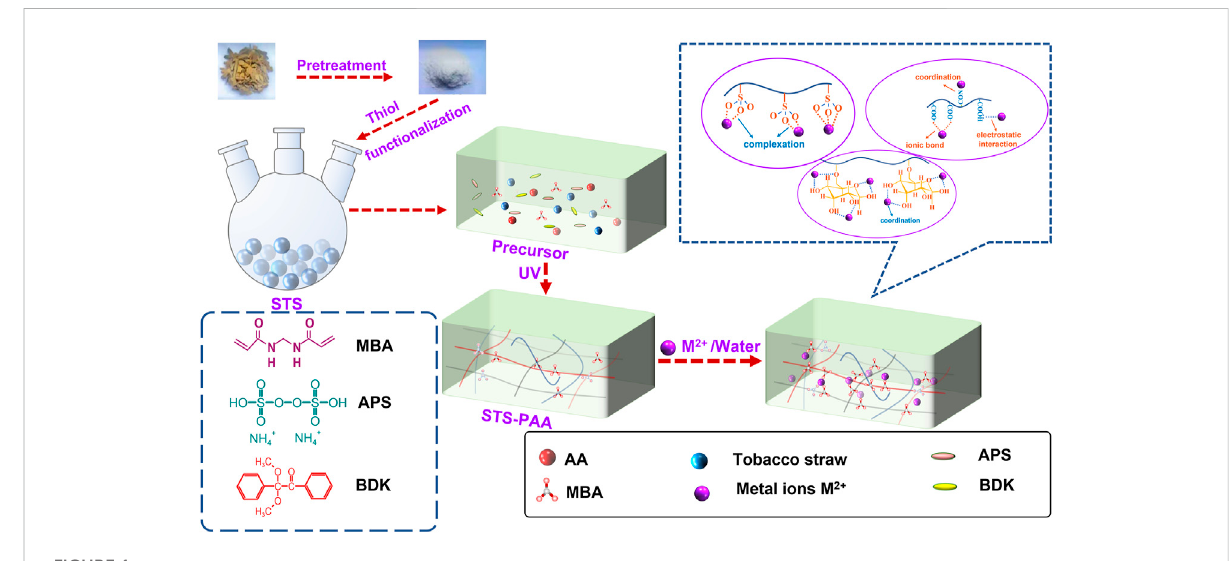
FIGURE 1 Synthesis and adsorption scheme for